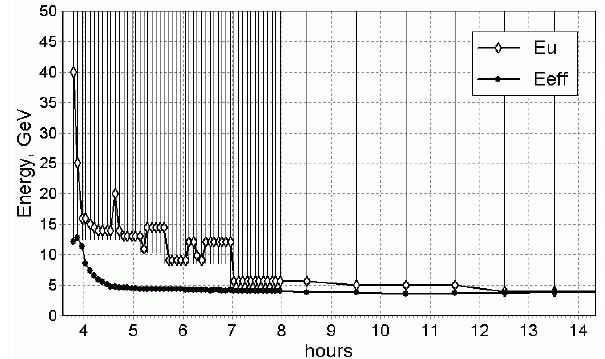
Figure 10 Fig. 10. Behavior of upper limited energy E u of solar CR (dia- monds) and their effective energy E eff from neutron monitor net- work registration. Fig. 12. Energy spectra of the CR mean flux at two different mo- ments of enhancement and peak spectrum for GLE 23 February de- rived from the neutron monitor data.